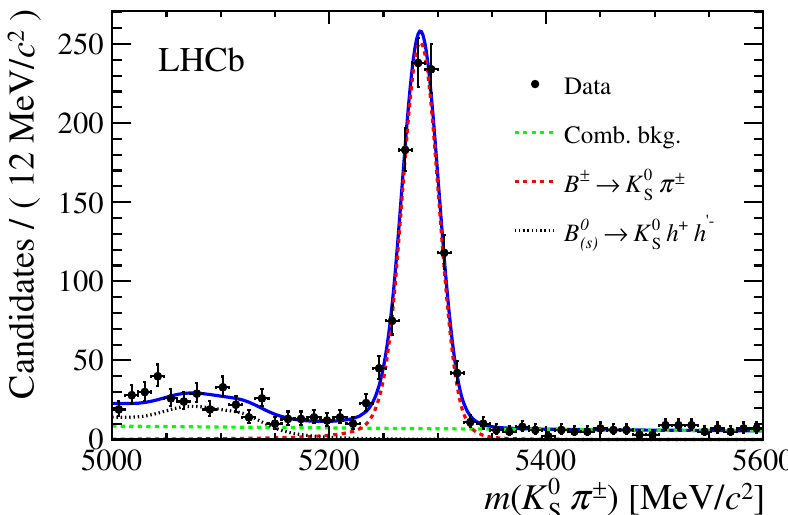
Figure 2 . Invariant mass distribution of K 0 (cid:25) + candidates after full selection. The result of the (cid:12)t S to the data (blue, solid) is shown together with each (cid:12)t model component, namely the B + ! K 0 signal, the B 0 ! K 0 h + h 0 (cid:0) partially reconstructed background, and the combinatorial ( s ) S